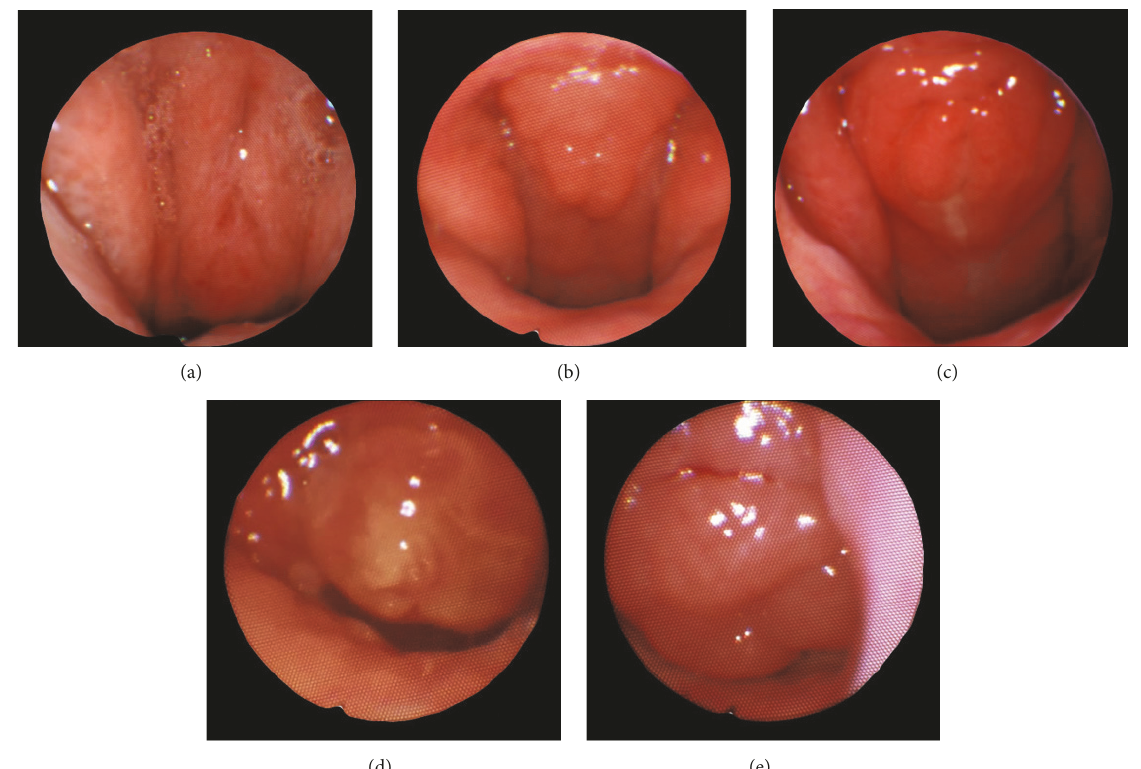
Figure 2: Adenoid hypertrophy grading system used at West Virginia University for Drug Induced Sleep Endoscopy. Grade 0 (0%) (a), Grade 1 ( < 40%) (b), Grade 2 (41%–70%) (c), Grade 3 (71%–90%) (d), and Grade 4 (91%–100%) (e).